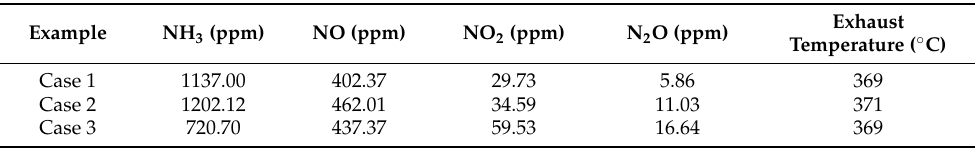
Table 8. Main residual exhaust gas and its concentration in the cylinder under different working conditions based on the 3D CFD simulation